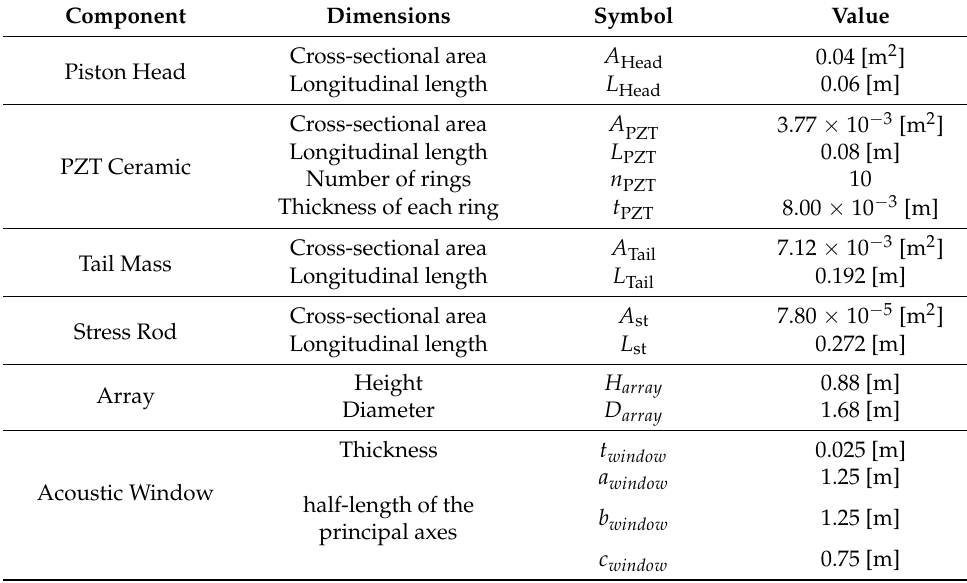
Table 2. Dimensions of the analysis model.